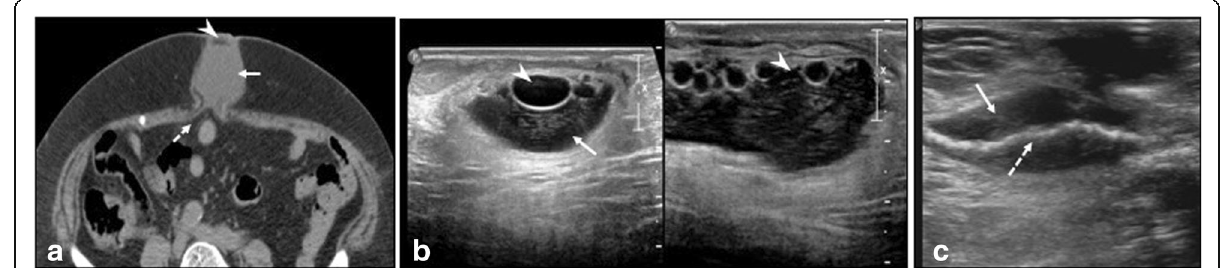
Fig. 5 Varying appearances of seroma post hernia repair. a Plain CT in axial section shows seroma (solid arrow) with fat levels (arrowhead). Dashed arrow is the mesh. b USG shows floating fat locules (arrowheads) secondary to tissue dissection within the seroma (arrow). c USG shows seroma (solid arrow) around the mesh (dashed arrow) in an early postoperative hernia repair